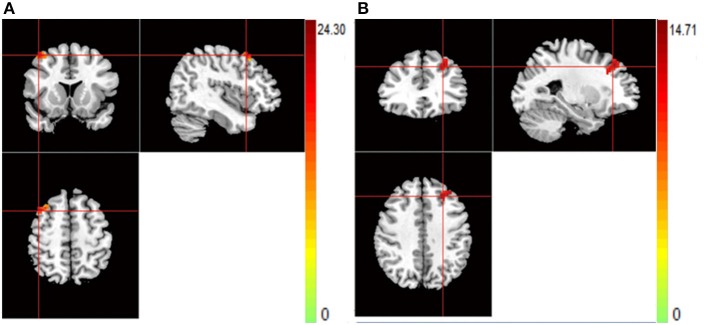
(A,B) The images show the main effect of genotypes. The hot color indicate that ReHo is lower when carrying the G-allele of rs821617, T-allele of rs821616 than homozygotes group for all subjects. (A) R-MFG for rs821617 (B) L-MFG for rs821616.